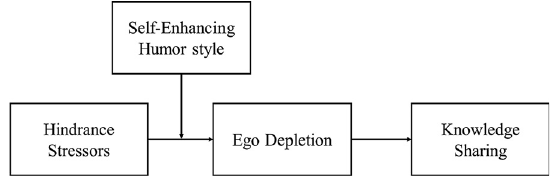
Figure 1. Theoretical model